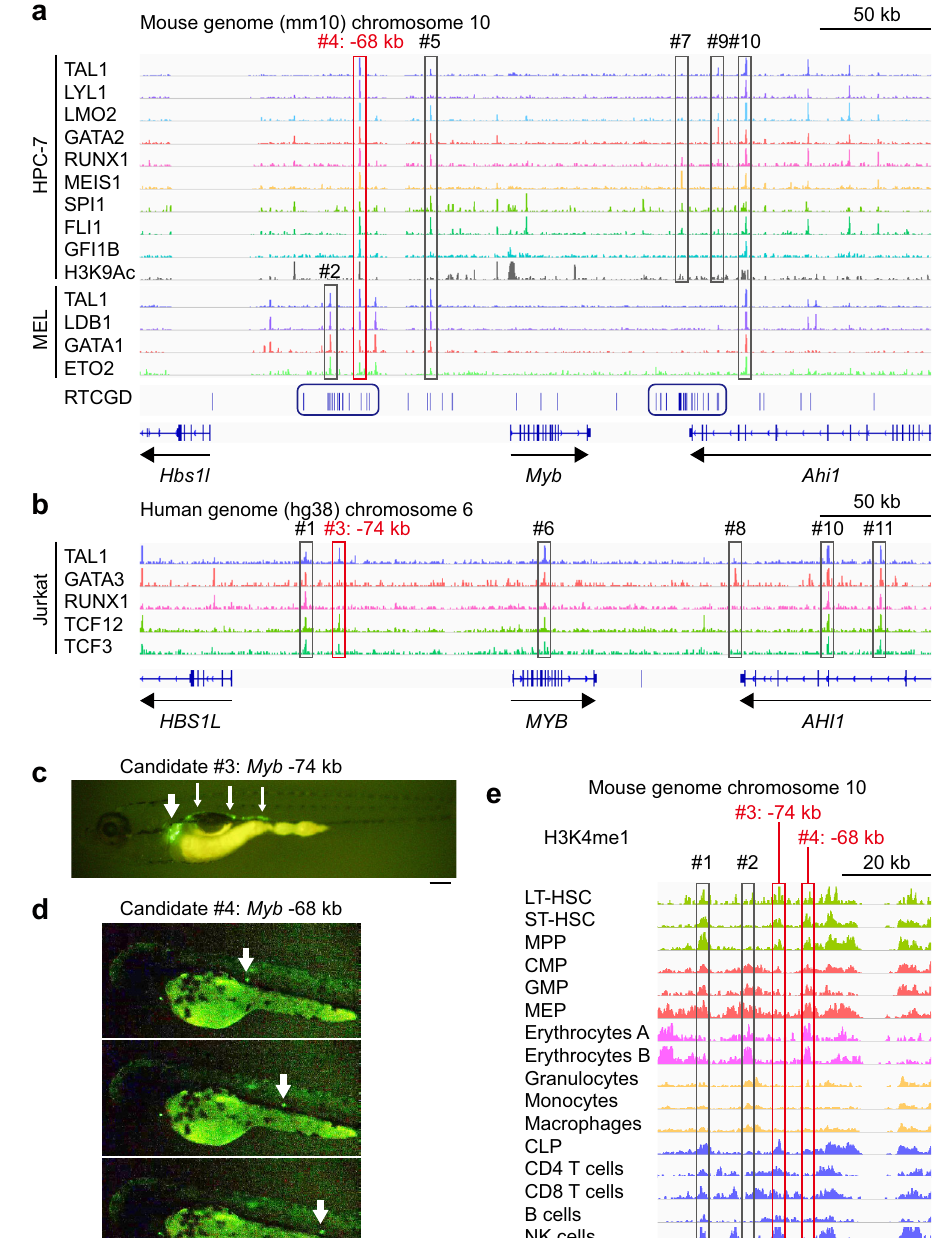
Fig. 1 | In silico analysis and in vivo validation using zebra fi sh to identify cis- regulatory elements of Myb . a , b Analysis of published ChIP-seq data demon- stratesthatmultipletranscriptionfactorsbindaroundthemouse Myb locusinHPC- 7 cells ( a , upper) and MEL cells ( a , lower) and the human MYB locus in Jurkat cells ( b ). A total of 11 candidate enhancer elements are shown in red or grey rectangles (#1to#11).Elements#4and#5arecommonbetweenHPC-7cellsandMELcells,and the element #10 is common among 3 cell lines. Two clusters of retroviral integra- tion sites (RIS) are indicated in blue rectangles. RTCGD Retrovirus Tagged Cancer Gene Database. c , d In vivo functional con fi rmation of selected regions using zebra fi sh. The candidatecis-regulatory elements were cloned into the upstreamof